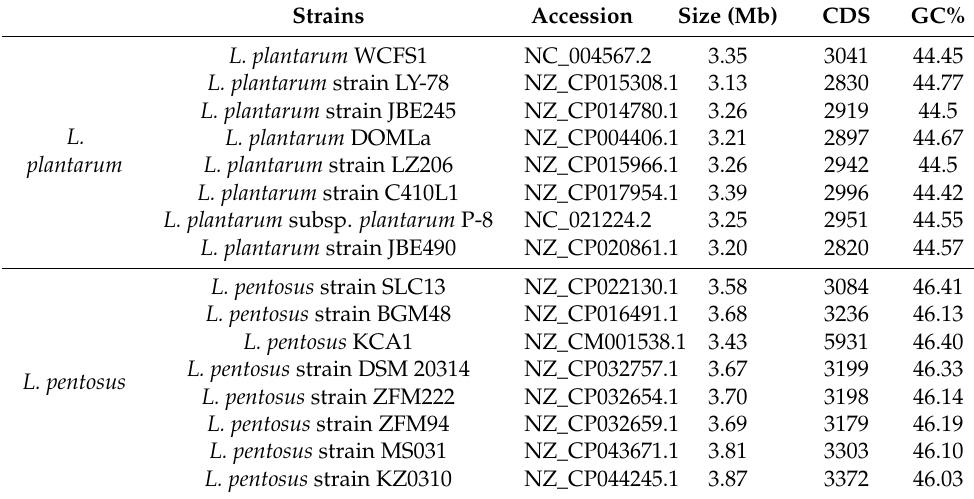
Table 4. Genome features of selected L. plantarum and L. pentosus . Strains Accession Size